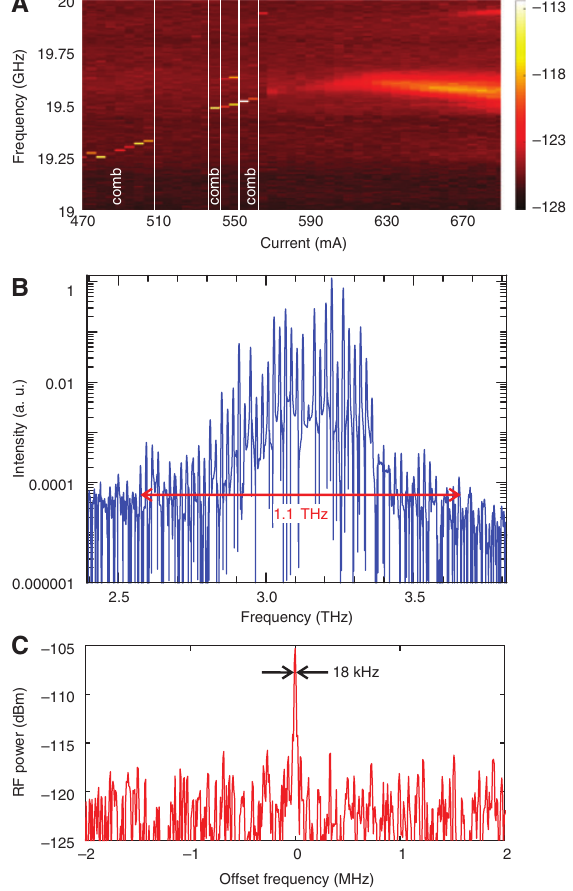
Figure 2: Frequency comb performance: (A) Intermode beatnote of a 2 mm × 60 μ m dry-etched laser as a function of the driving current. The temperature is fixed to 20 K. The beatnote signal is extracted from the bias line with a bias-tee and is recorded with an RF spectrum analyzer (Rohde & Schwarz FSU50; RBW: 10 kHz, video bandwidth (VBW): 100 kHz, sweep time (SWT): 10 s). (B) Optical spectrum for the same laser at 562 mA at 16 K. For this current the laser is in a FC regime providing a bandwidth of 1.1 THz. (C) Inter- mode beatnote of the same laser under the same driving conditions as in (B) recorded with an RF spectrum analyzer (RBW: 10 kHz, VBW: 100 kHz, SWT: 20 ms). The linewidth is limited by the RBW of the spectrum